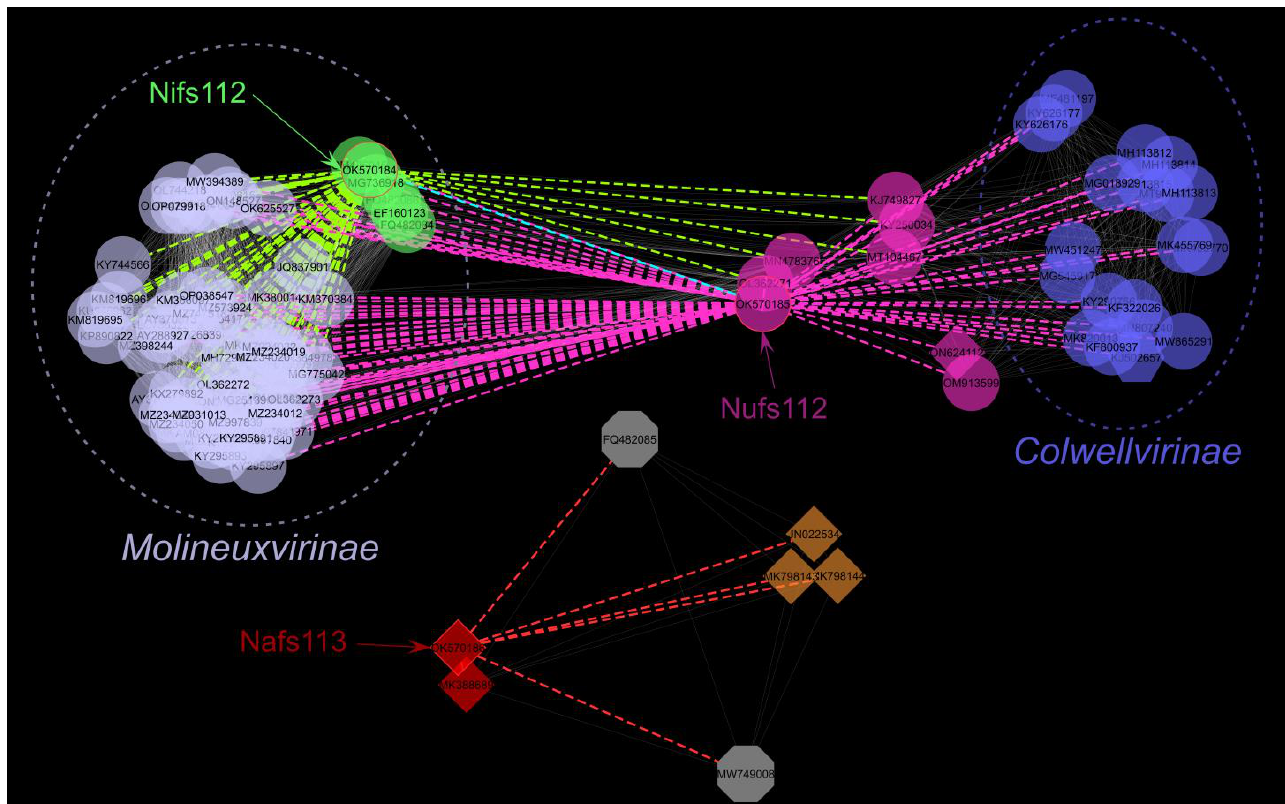
Figure 4. Sub-network containing first neighbors of the studied phages under edge-weighted spring-embedded layout (n = 103). Nodes are colored according to the viral cluster as identified by vConTACT2 for a network generated from 18,553 complete phage genomes: VC_436_0 (n = 62) — light blue; VC_437_0 (n = 6) — green; VC_961_0 (n = 20) — dark blue; VC_62_0 (n = 3) — brown; VC_794_0 (n = 2) — red; outliers (n = 2) — grey; phages that were determined to be classified as an overlap between two viral clusters (VC_439/VC_962; n = 8) that were not present in the sub-network — magenta. Different node shapes correspond to different viral families: circle — Autographiviridae ; octagon — Myoviridae (recently abolished); hexagon — Drexlerviridae ; diamond — unclassified at the family level. Dashed ellipses enclose recognized and tentative Molineuxvirinae (light blue) or Colwellvirinae (dark blue) phage subfamily representatives. Dashed colored edges represent links to the studied phages: green — Nifs112; magenta — Nufs112; red — Nafs113. Mutual link between Nifs112 and Nufs112 is represented by cyan dashed line.